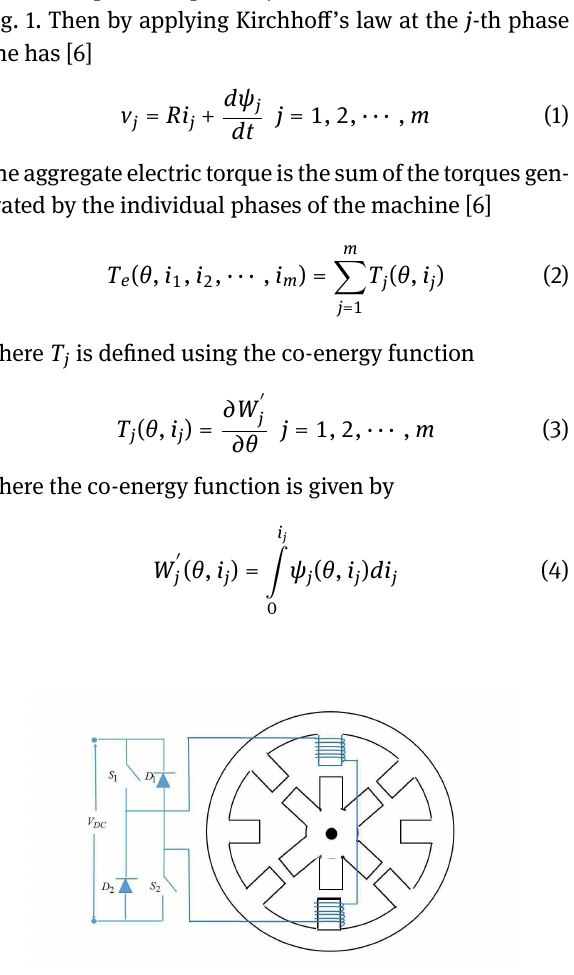
Fig. 1. Then by applying Kirchhoff’s law at the j -th phase